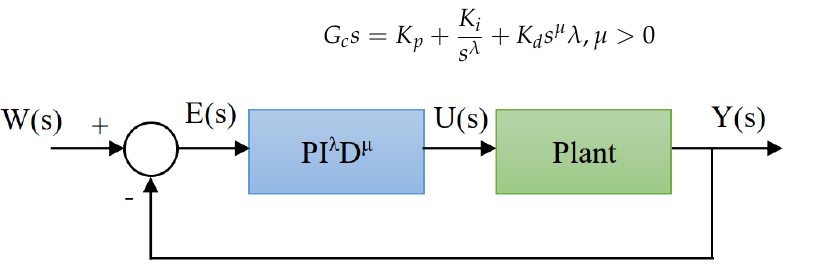
Figure 3. Block diagram of FOPID controller with